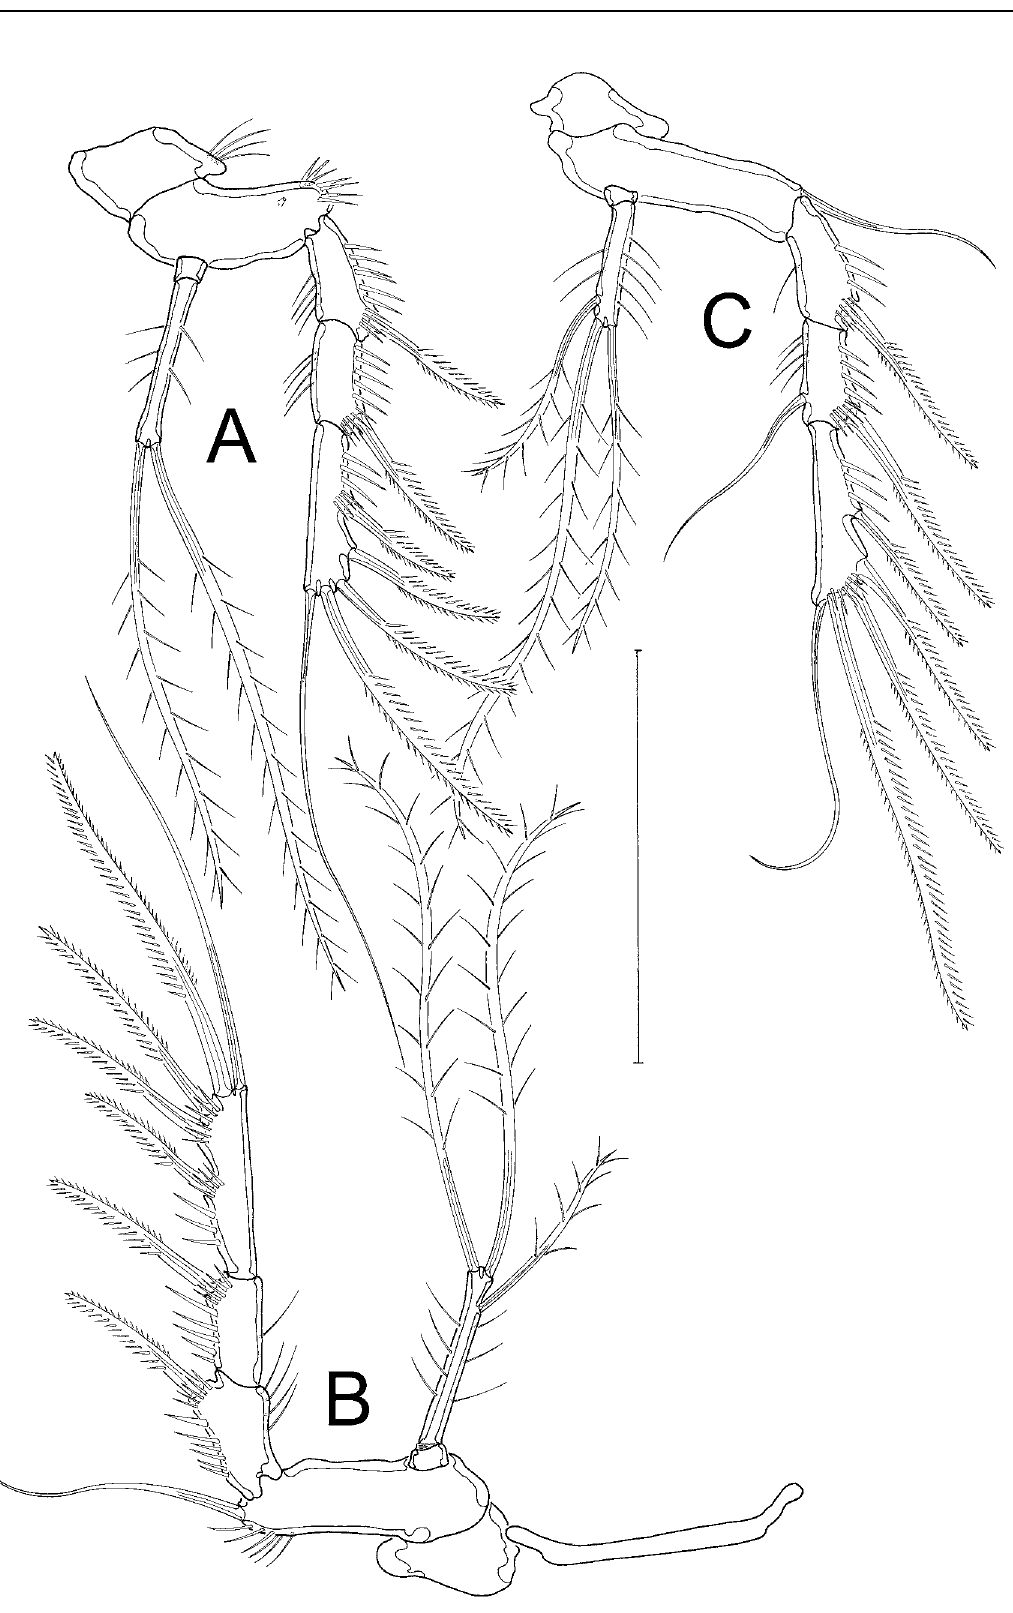
Fig. 11. Laophontodes sarsi sp. nov., holotype ♀ (NHM F20298-1). A . P2. B . P3. C . P4. Scale bar = 50